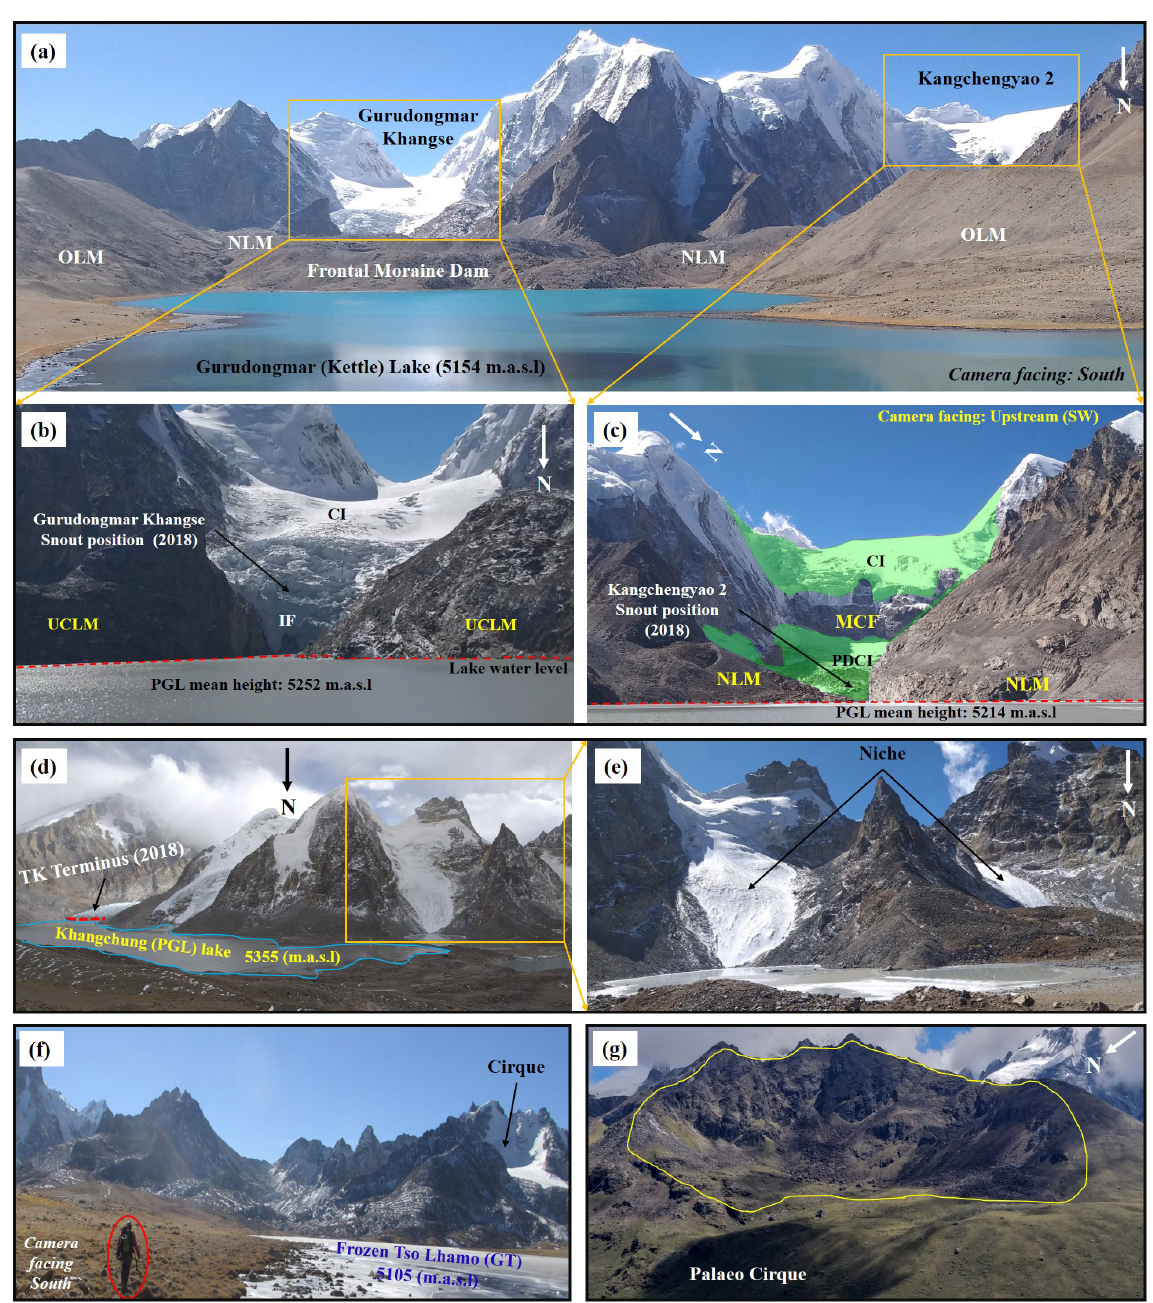
Figure 3. Field photographs (2017–2018) showing different glaciers and associated geomorphology in the study region (see Fig. 1 for location). (a) Panoramic view of glaciers in the Gurudongmar region; (b, c) closer view of Gurudongmar and Kangchengyao-2 glaciers; (d) different morphological types of glaciers in the Tista Khangse region; (e) closer view of some niche glaciers near Tista Khangse; (f) Tso Lhamo region; (g) unknown palaeo-cirque in the Lashar valley, Thangu. Note the following abbreviations: CI, clean ice; GT, glacial tarn; IF, icefall; MCF, mountain cliff face; NLM, new lateral moraine; OLM, old lateral moraine; PDCI, partially debris-covered ice; PGL, proglacial lake; TK, Tista Khangse; UCLM, unconsolidated lateral moraine. The red oval surrounding the person in (f) represents the scale of the image. (All photos courtesy of Arindam Chowdhury, taken in